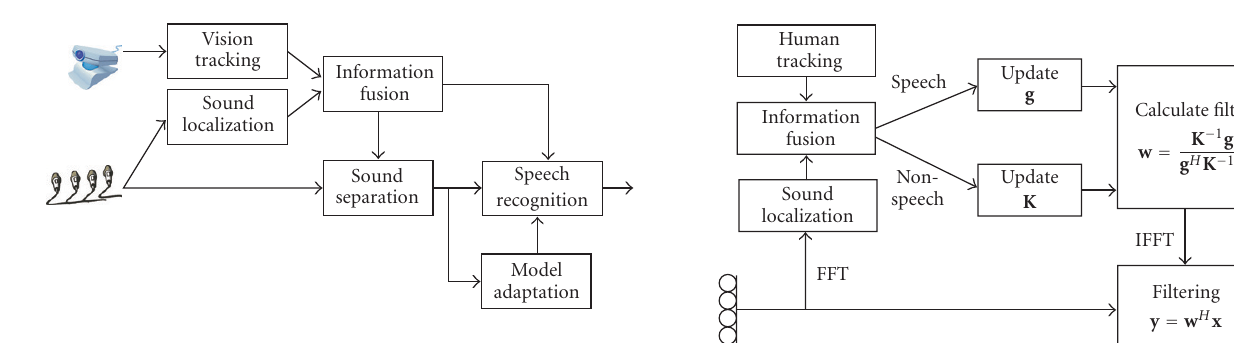
Figure 7: Block diagram of the proposed audio-video information fusion system.